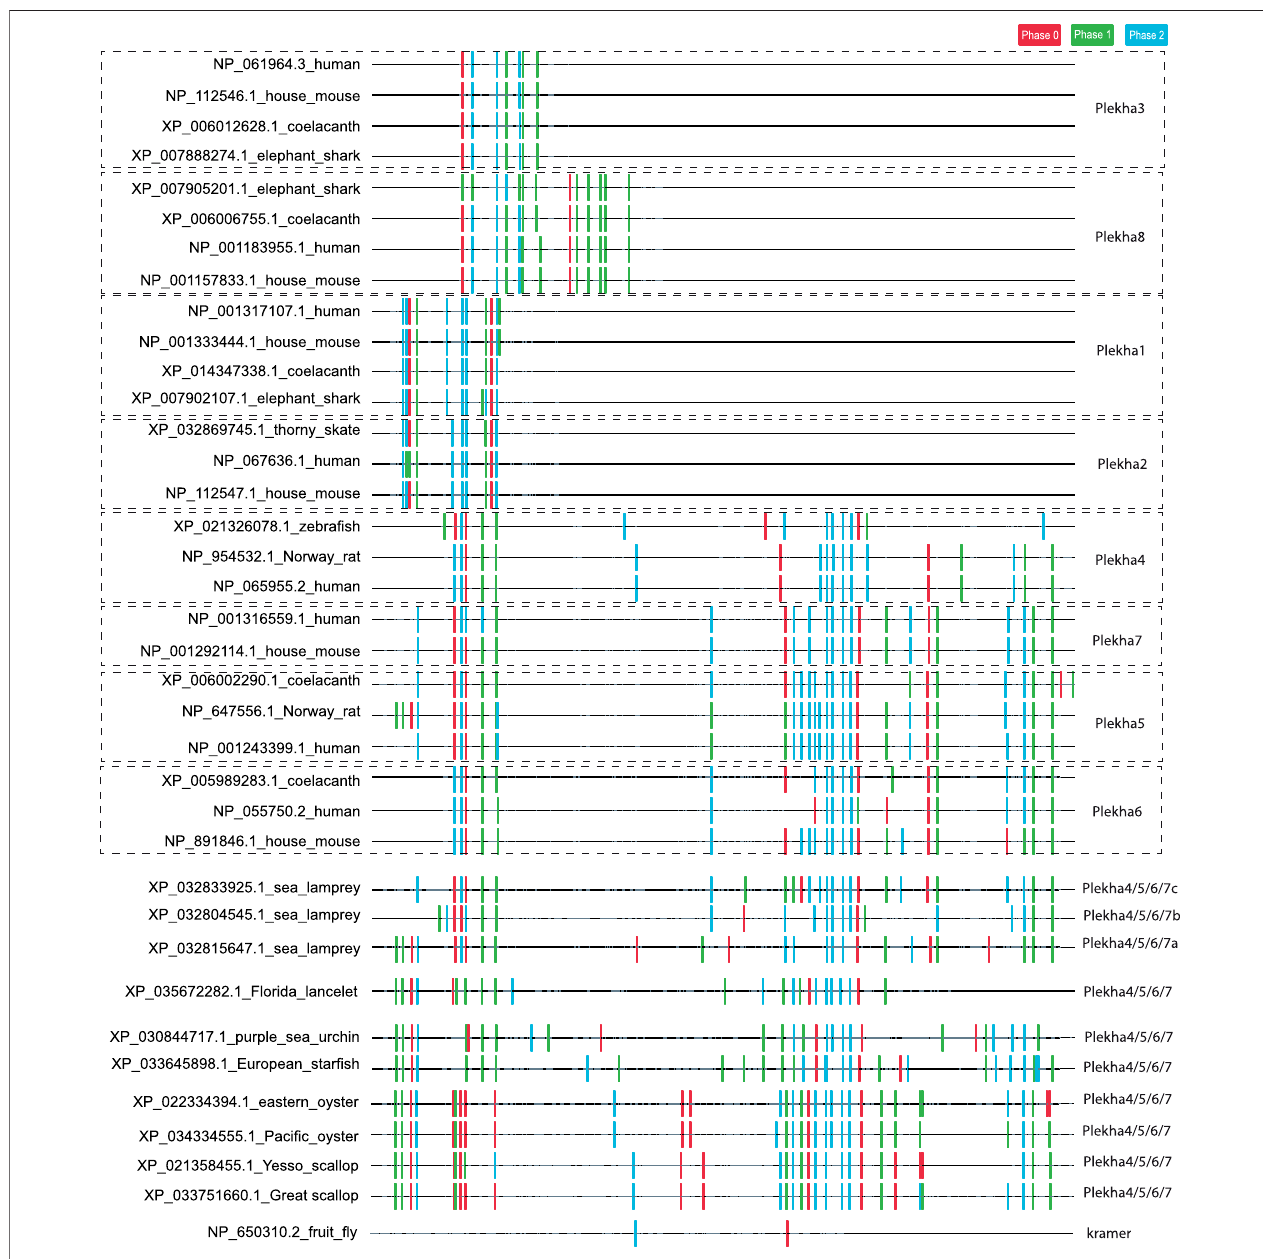
FIGURE 3 | Analysis of intron position and phase con fi rms the existence of three distinct PLEKHA subfamilies and reveals similarities and differences between vertebrate and invertebrate Plekha4/5/6/7 genes. The fi gure depicts the position and phase of introns within Plekha genes from representative species. Intron positions were mapped on a multiple sequence alignment. The introns are denoted with colored boxes (phase 0: red; phase 1: green; phase 2: blue). The parts of the multiple sequence alignment that contain information (amino acids) are shown as black lines and the ones containing alignment gaps are shown are light grey lines. The intron collection, mapping, and coloring were performed using in-house scripts (see Methods).